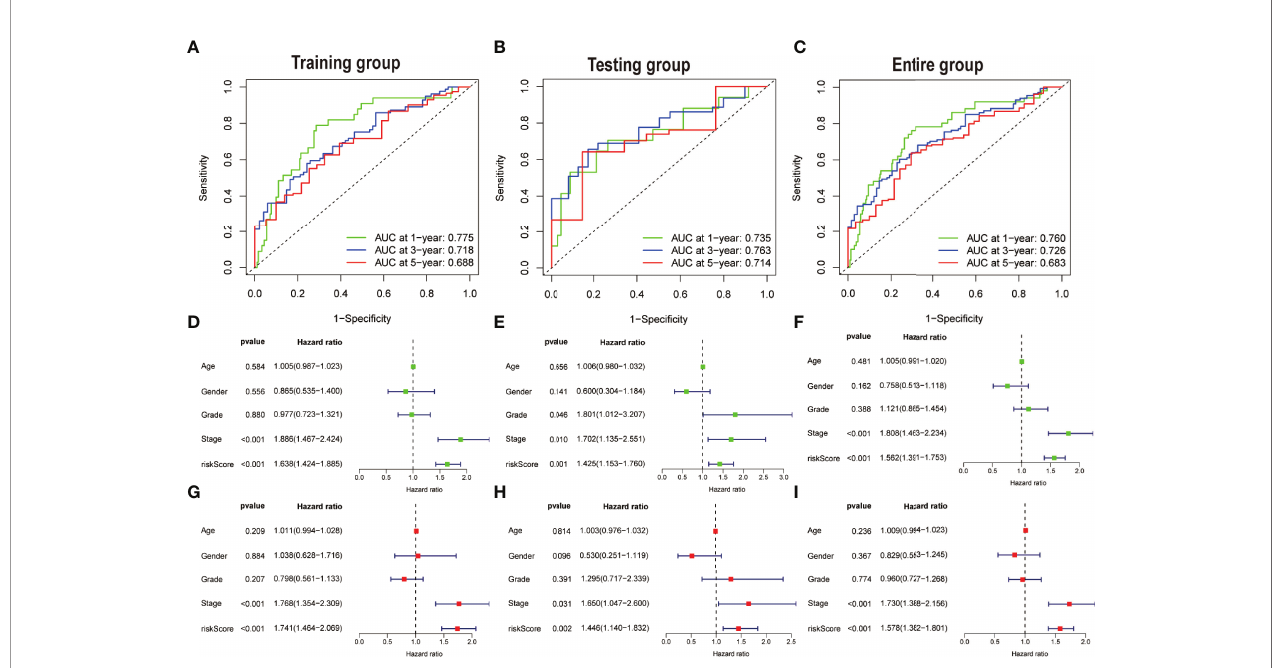
FIGURE 5 | Assessing the accuracy and independence of the model. Curves of receiver operating characteristic (ROC) related to prognostic signature for predicting the 1, 3, and 5 years of survival in the (A) training, (B) testing, and (C) entire set. Univariate Cox regression results in the (D) training, (E) testing, and (F) entire set. Multivariate Cox regression results in the (G) training, (H) testing, and (I) entire